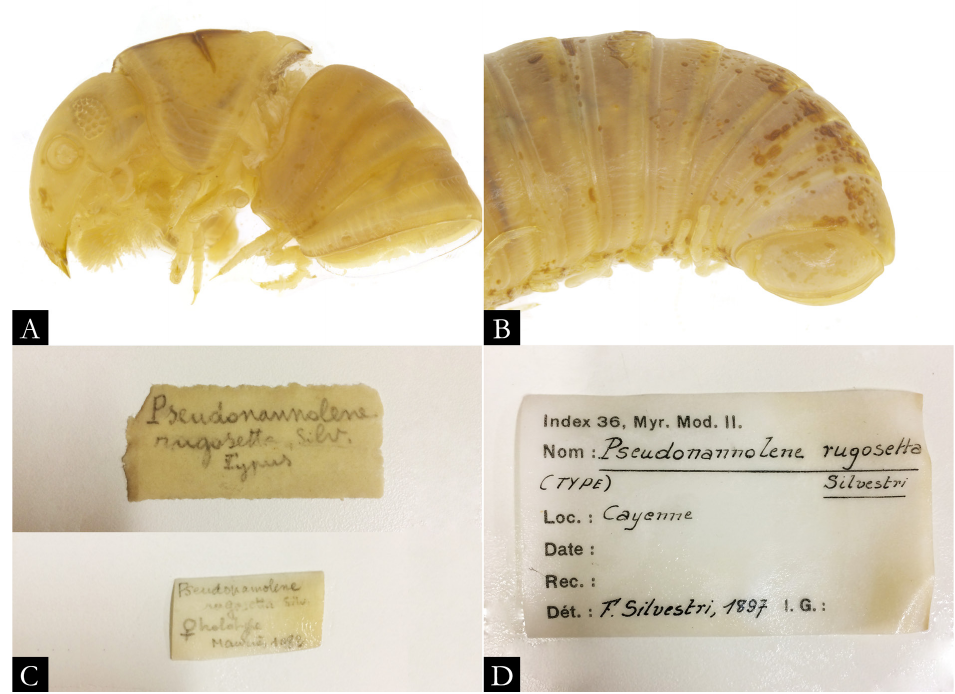
Fig. 162. Pseudonannolene rugosetta Silvestri, 1897, ♀ holotype (ISNB). A . Anterior region, in lateral view. B . Posterior region, in lateral view. C–D . Original labels of type material. Images not to